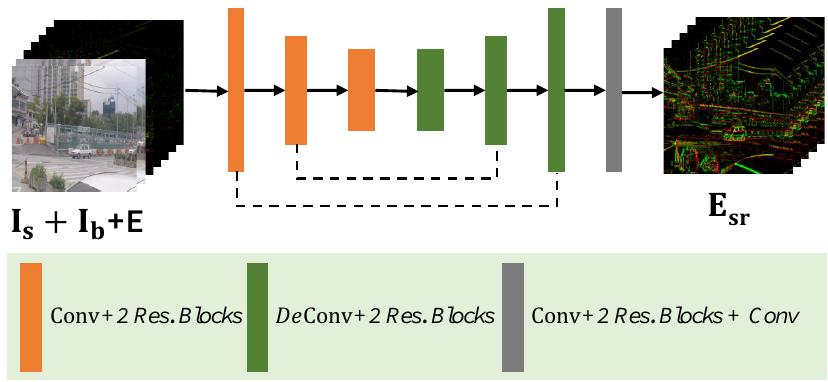
Figure A2. Framework of EventSRNet.